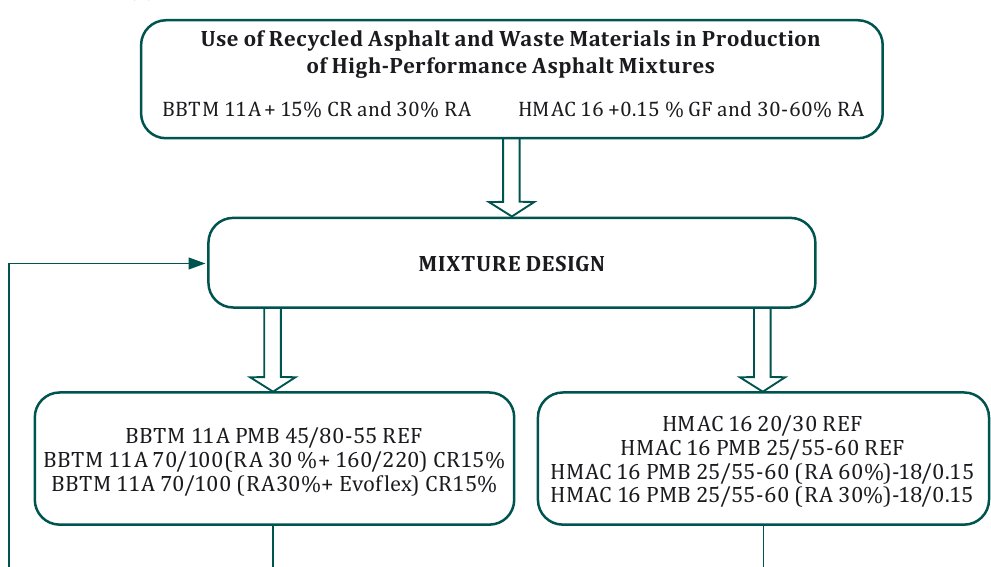
Low temperature cracking, rutting, moisture susceptibility, SCB, four point bending test